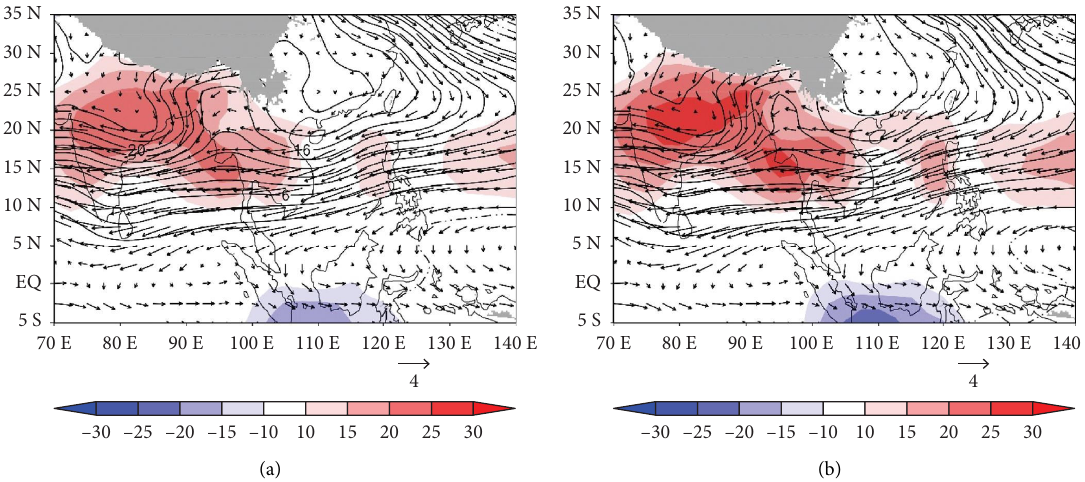
Figure 9: Same as Figure 8 except for the 300hPa zonal wind (a) and 500 hPa geopotential height indices (b). (a) OLR,wind, hgt regressed on U-index. (b) OLR,wind, hgt regressed on